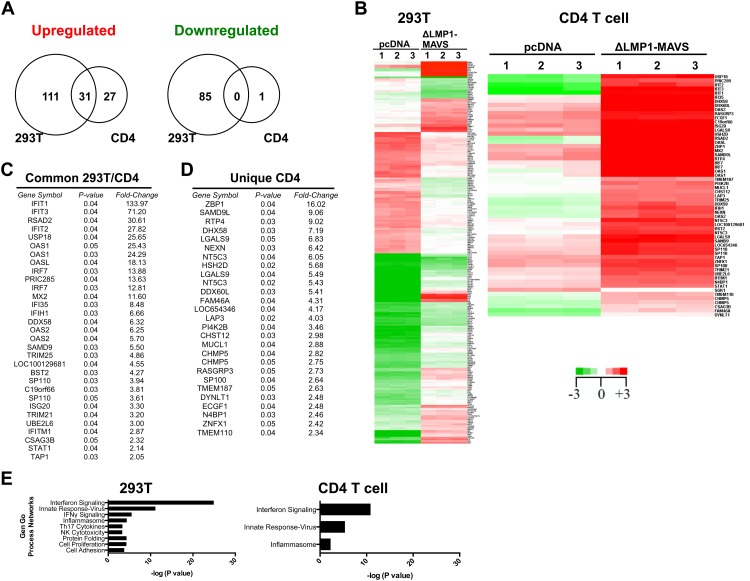
Gene array analysis of transfected 293T cells and primary CD4+ T cells cultured with 293T supernatant.Three independent wells of 293T cells were transfected with pcDNA3.1 empty vector or ΔLMP1-MAVS plasmid and total RNA isolated 36 hours later. Primary CD4+ T cells from 3 independent donors were cultured with 293T supernatant (collected 24 hours following pcDNA3.1 or ΔLMP1-MAVS transfection). Total CD4+ T cell RNA was isolated 36 hours later. (A) Venn Diagrams of the number of probe sets upregulated and down-regulated (>2-fold change) by ΔLMP1-MAVS. (B) Differential gene expression of 293T cells and CD4+ T cells. (C) List of genes upregulated by ΔLMP1-MAVS in both 293T cells and CD4+ T cells. Fold-change and P-values for each probe set are shown for CD4+ T cells following ΔLMP1-MAVS treatment. (D) List of genes upregulated by CD4+ T cells but not 293T cells. Fold-change between pcDNA3.1 and pΔLMP1-MAVS and P-values for each probe set are shown. (E) Gen Go networks analysis of pathways significantly upregulated by ΔLMP1-MAVS in transfected 293T cells, or CD4+ T cells cultured with ΔLMP1-MAVS transfected 293T supernatant.